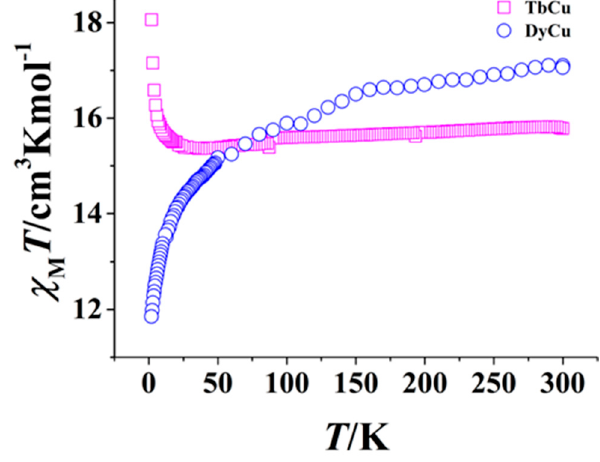
Figure 5. χ M T vs. T plots for complexes 3 ( TbCu ) and 4 ( DyCu ).